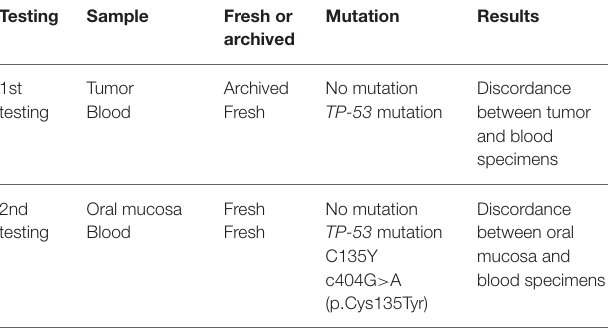
TABLE 2 | Results of genomic tests in a patient with TP53 -mutated